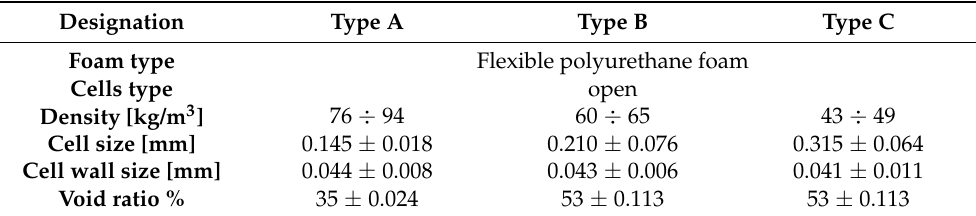
Figure 1. From left to right, cubic samples of the type A, type B, and type C foams. The dimensions, expressed in mm, are the same for all the specimens ( a ). Microstructure obtained by a Nikon SMZ- 800 stereoscopic microscope (Nikon Corporation, Tokyo, Japan) with a 20× magnification for the type A ( b ), type B ( c ), and type C ( d ) foams. Table 1. Designation and characteristics of the tested foams.